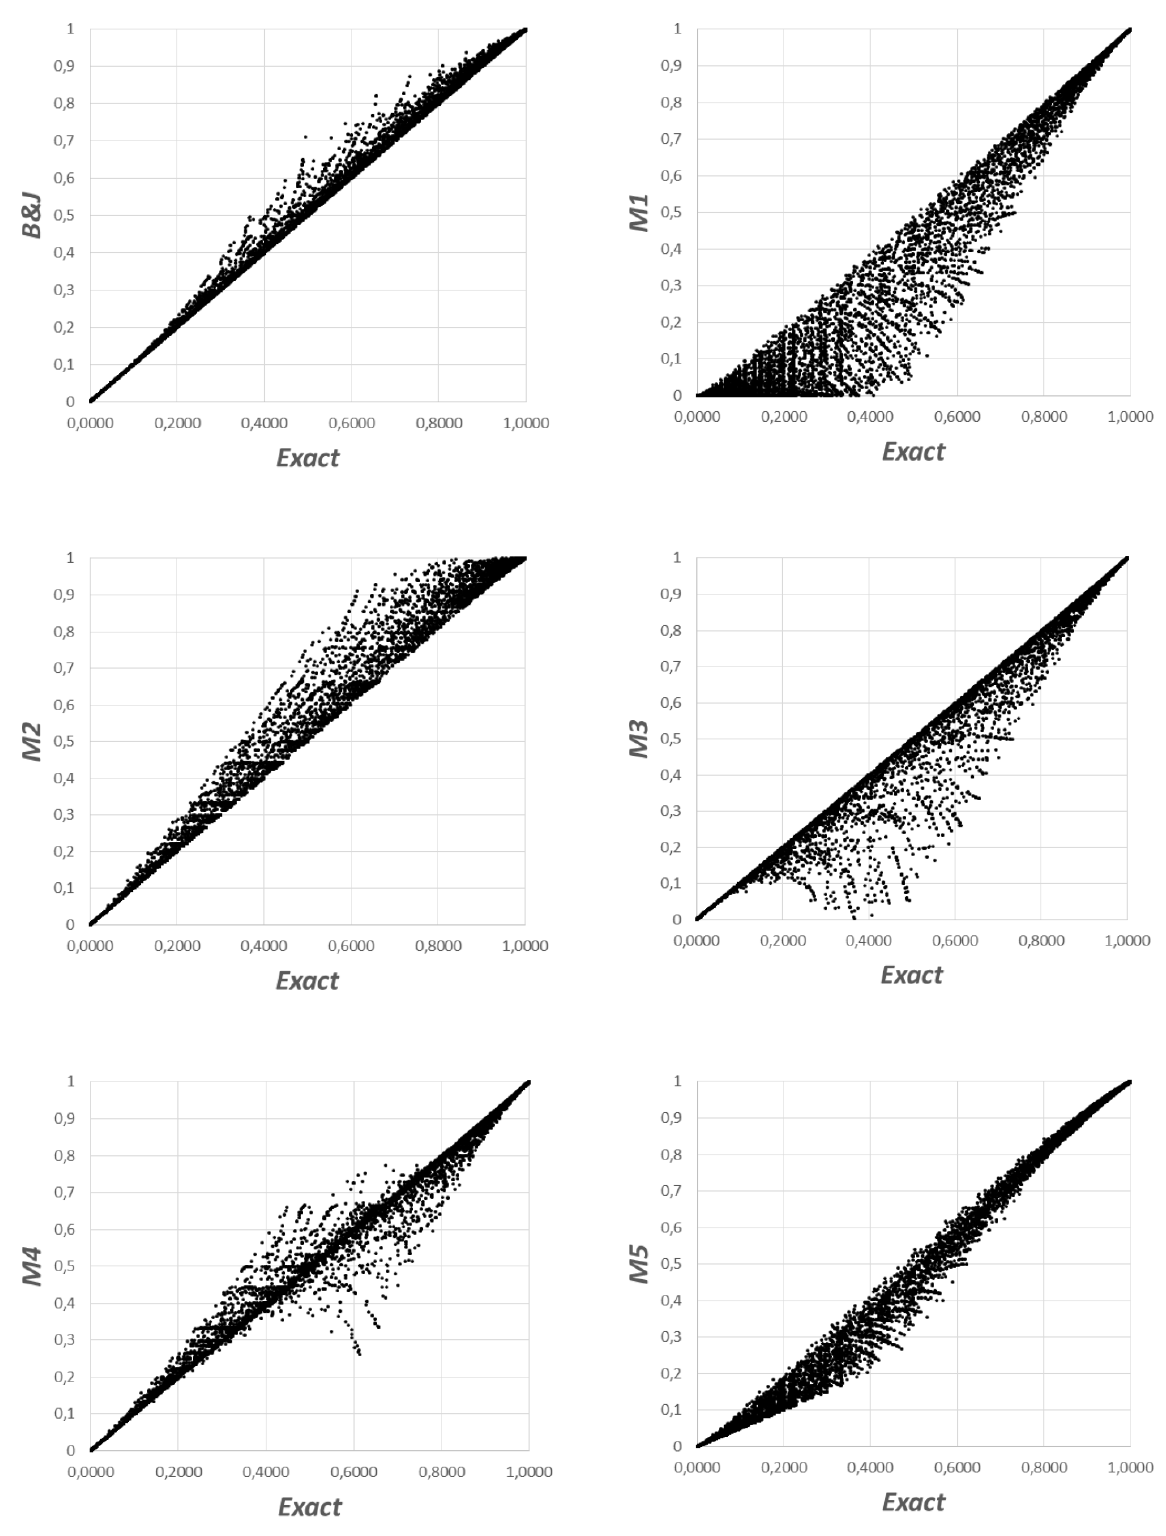
Figure 2. Fill rate estimates against the exact value for the considered